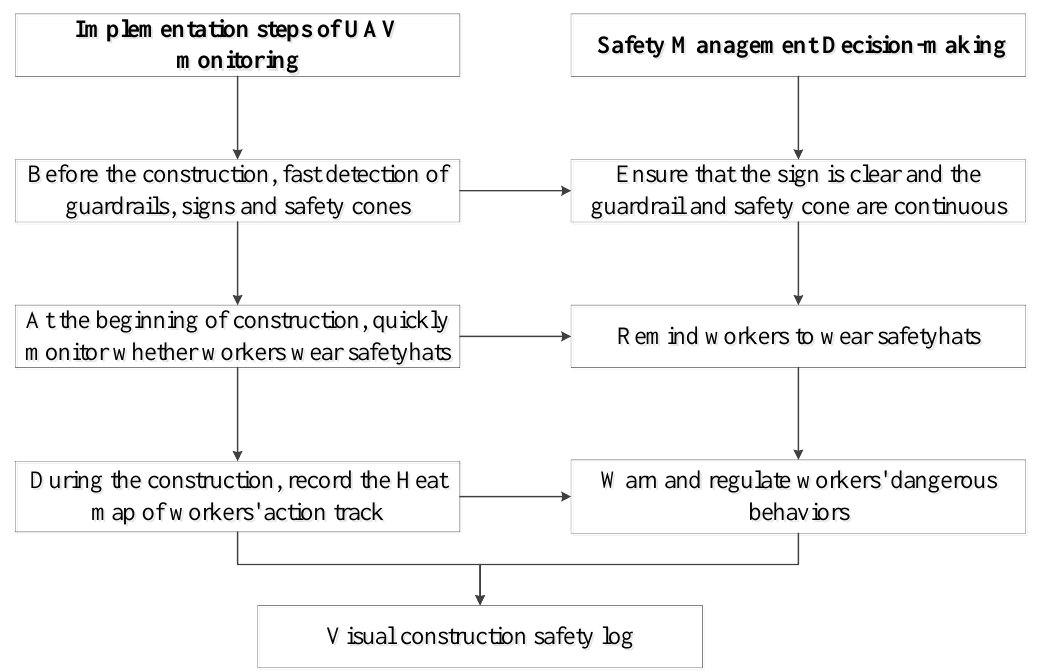
Figure 3. Implementation of UAV safety monitoring.